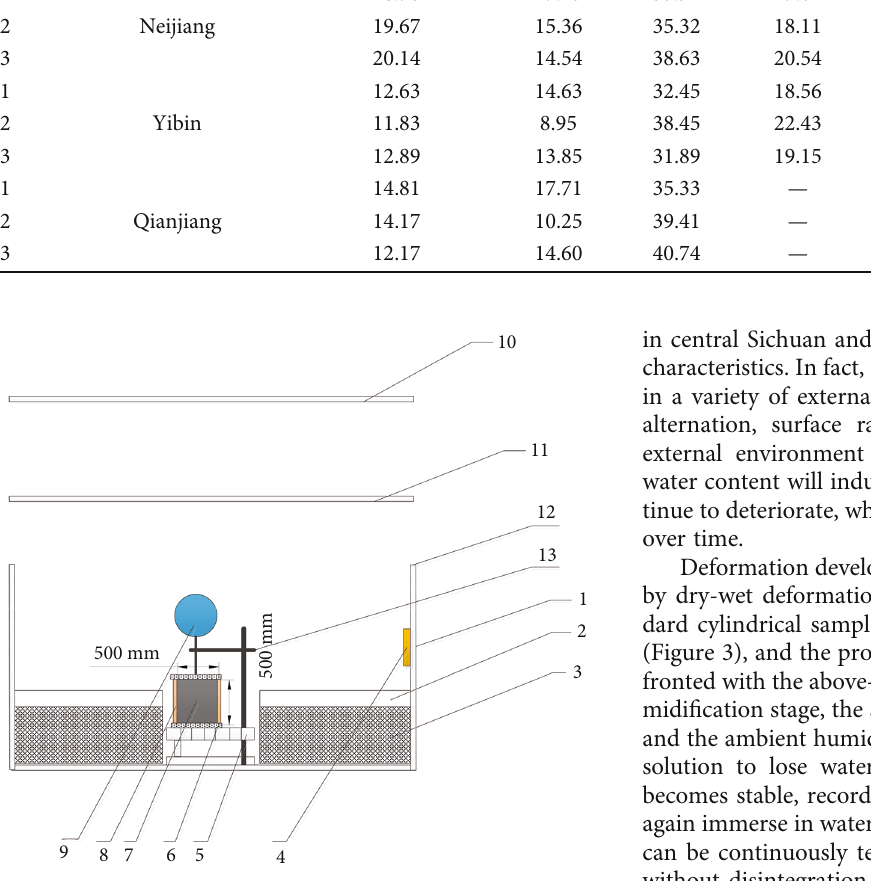
Figure 6: Schematic diagram of dry and wet deformation test. Note: 1: device for controlling humidity; 2: opening vessel; 3: saturated salt solution; 4: thermometer and hygrometer; 5: perforated acrylic plate; 6: porous stone; 7: rock sample; 8: lateral restraint; 9: dial gauge; 10: upper sealing plate; 11: lower sealing fi lm; 12: sealing tape; 13: fi xed